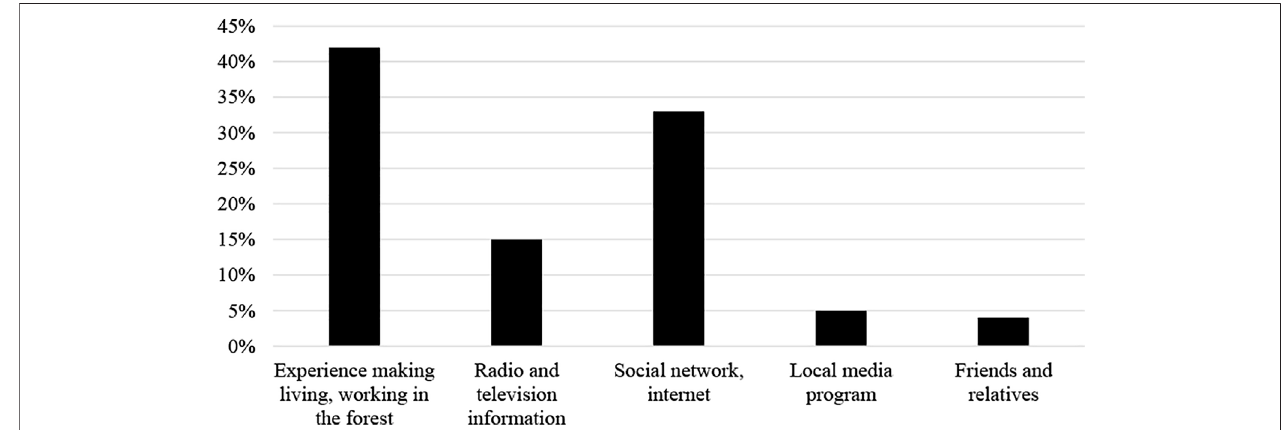
FIGURE 4 | The main sources of information on ecosystem values of the forest to the household heads (%).